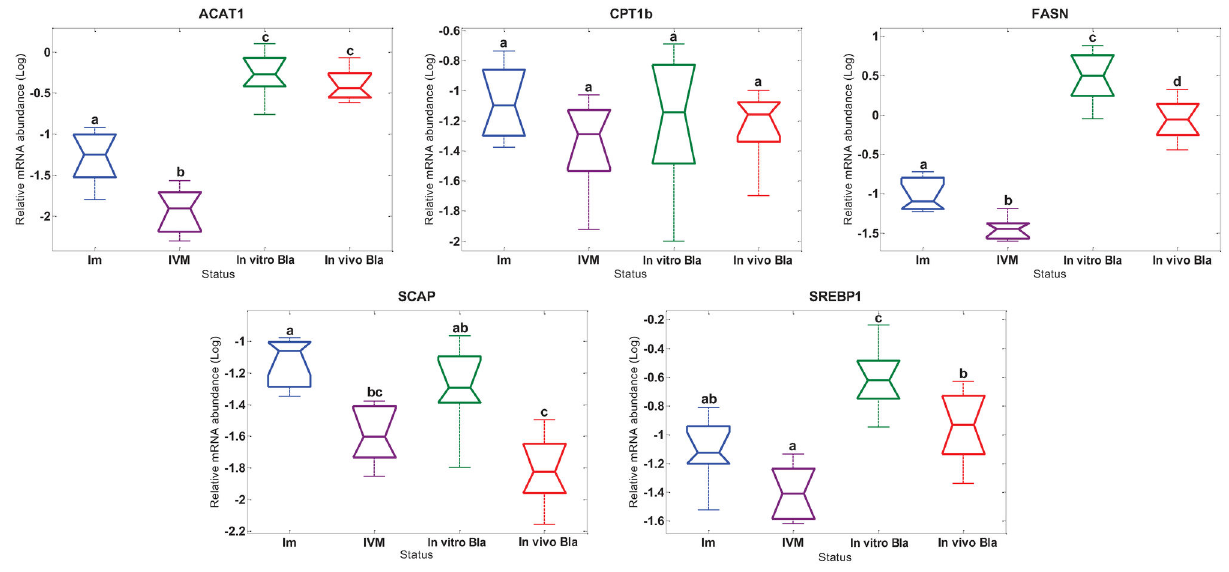
Figure 4. Relative poly (A) + mRNA abundance of target genes. Box plot of Log converted data (with median, 25th and 75th quartiles and max and mix values) based on single oocytes/embryos preparation: immature oocytes, n=8 (Im); in vitro matured oocytes, n=8 (IVM); in vitro produced blastocysts, n=7 ( In vitro Bla); in vivo produced blastocysts, n=8 ( In vivo Bla). Different superscripts indicate significant differences (P< 0.05). doi: